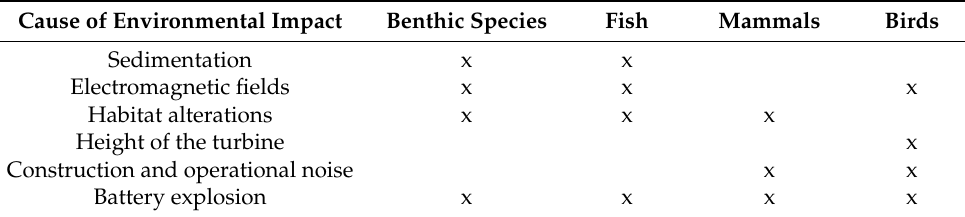
Table 6. Overview of the marine classes affected by different causes of environmental impact. Cause of Environmental Impact Benthic Species Fish Mammals Birds Sedimentation x